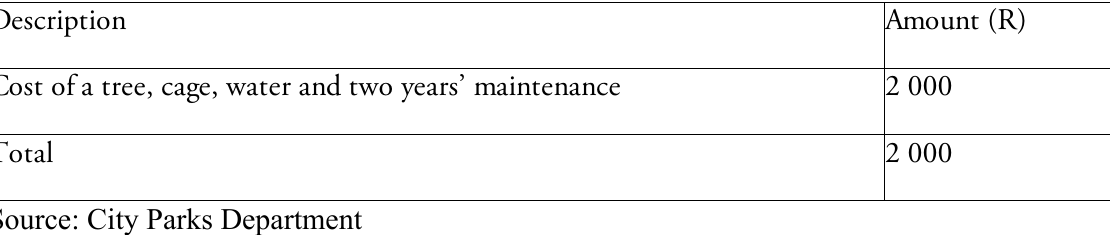
Table 3: Costs of a casuarina tree-planting intervention Description